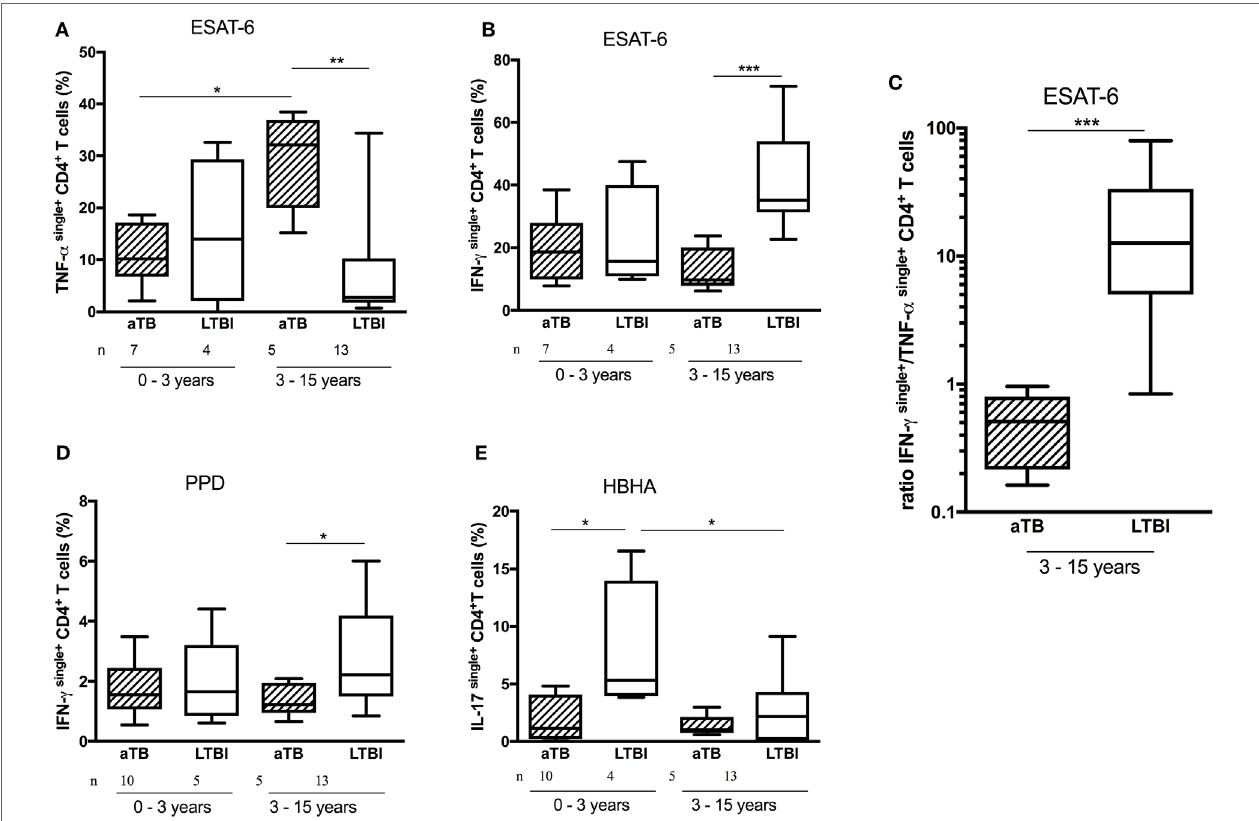
FigUre 4 | Age-related differences in CD4 + T cell cytokine profiles. Peripheral blood mononuclear cells were in vitro stimulated during 5 days with early-secreted- antigenic target-6 (ESAT-6), purified protein derivative (PPD), or heparin-binding hemagglutinin (HBHA), and the frequency of cytokine single + CD4 + T cells was analyzed and compared between infected children who were younger or older than 3 years of age, and between active TB (aTB) (hatched columns) and latently TB infected (LTBI) children (open columns). Among older children, the frequency of ESAT-6-induced TNF- α single + CD4 + T cells (a) was higher and the frequencies of both ESAT-6- and PPD-induced IFN- γ single + CD4 + T cells were lower (b,D) among children with aTB compared to LTBI children. This resulted in lower ratios between the proportions of ESAT-6-induced IFN- γ single + and ESAT-6-induced TNF- α single + CD4 + T cells in children older than 3 years (c) . By contrast, in children younger than 3 years, only the frequency of IL-17 single + CD4 + T cells was higher among LTBI children compared to those with aTB (e) . Results are illustrated as medians (horizontal bars), 10th–90th percentiles (boxes) and ranges. *** p < 0.005; ** p ≤ 0.01; * p <